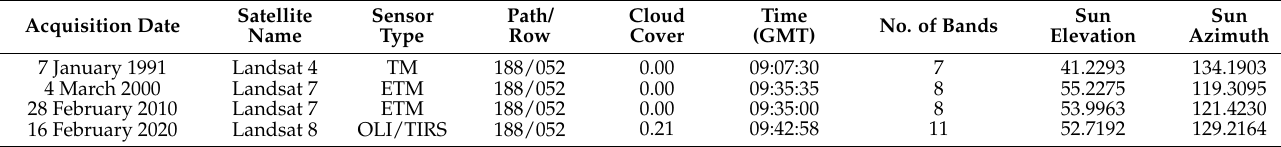
Figure 1. The study area (Kano Metropolis, Nigeria). Table 1. Satellite Dataset used in the